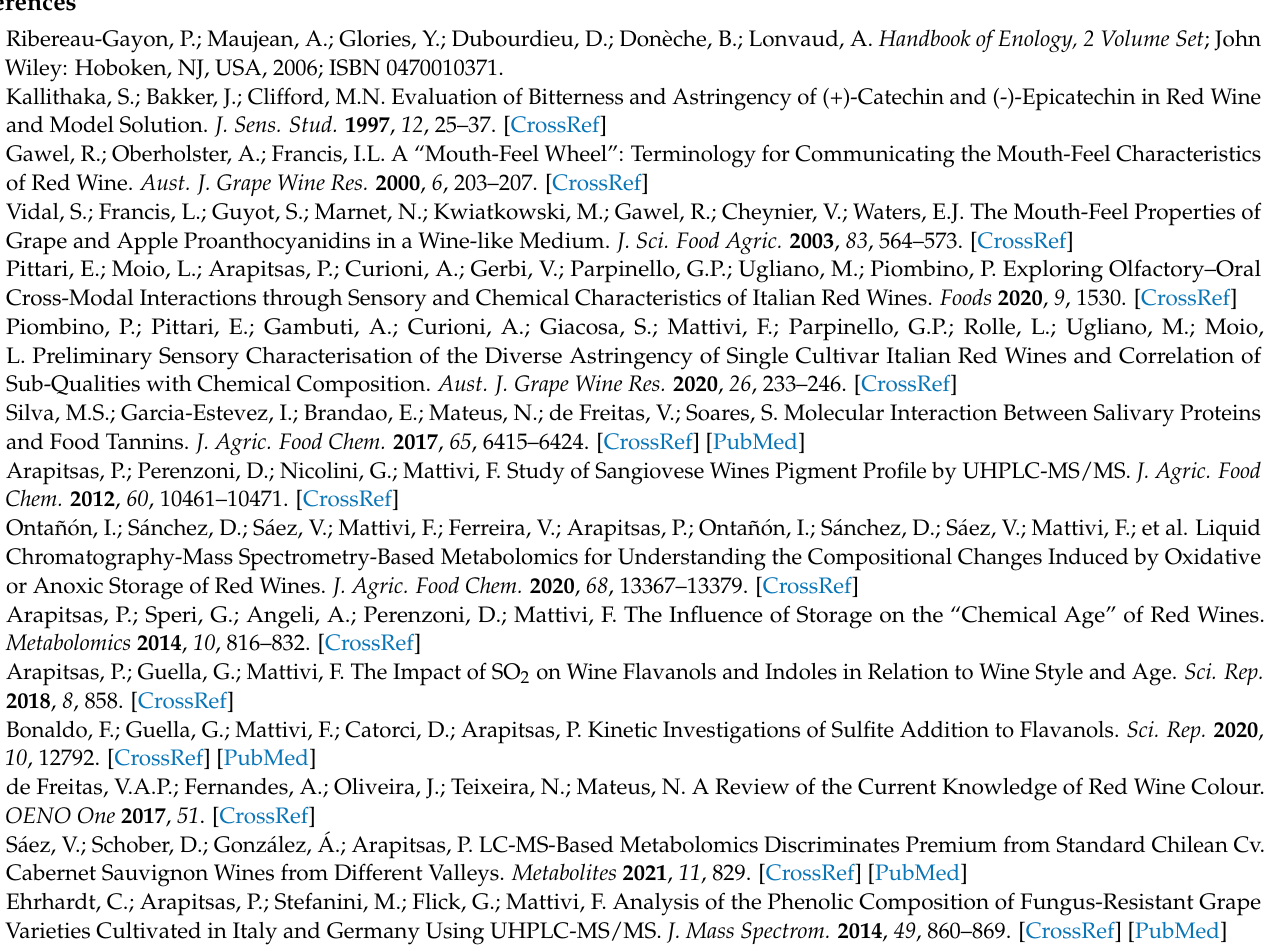
values; Table S5. Basic statistics and ANOVA analysis of the terminal units’ percentage values; Table S6. Basic statistics and ANOVA analysis of the upper units’ absolute values; Table S7. Basic statistics and ANOVA analysis of the upper units’ percentage values; Formulas for the